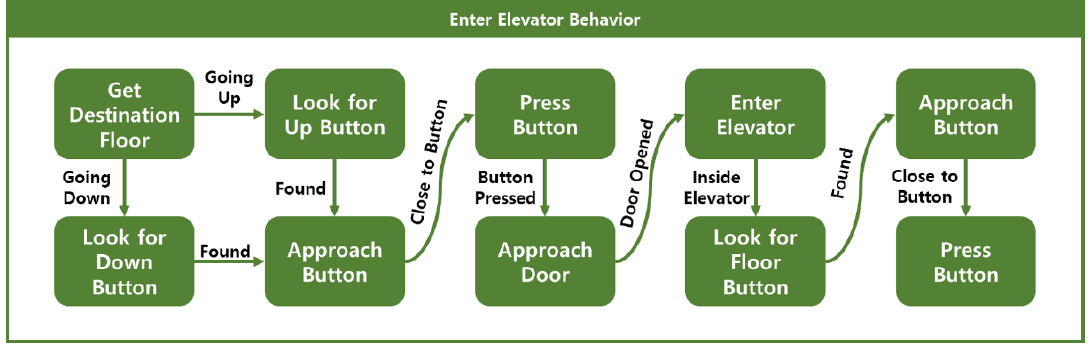
Figure 7. A Finite State Machine diagram showing a simplified version of the Enter Elevator behavior stored on the Behavior